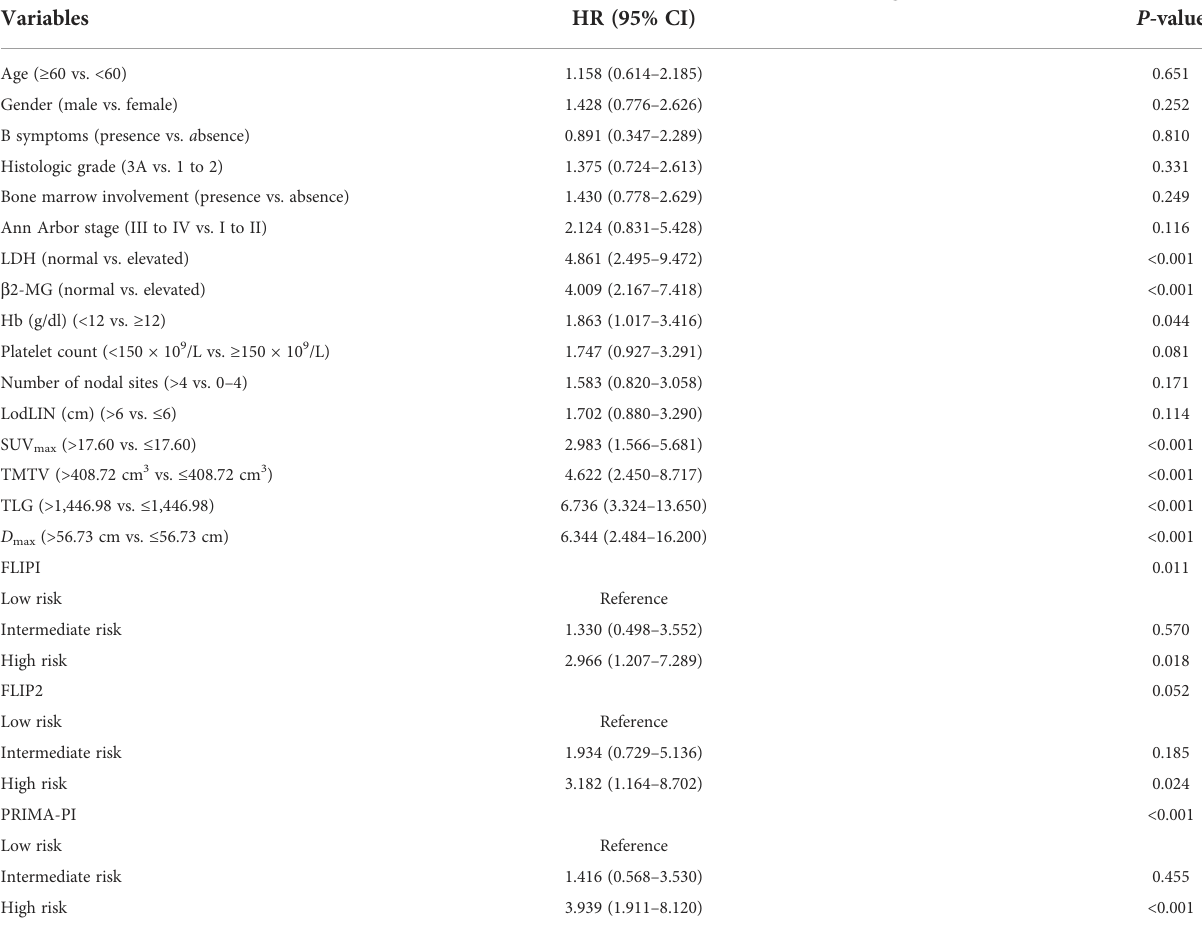
TABLE 2 Variables associated with progression-free survival (PFS) in the univariate analysis.